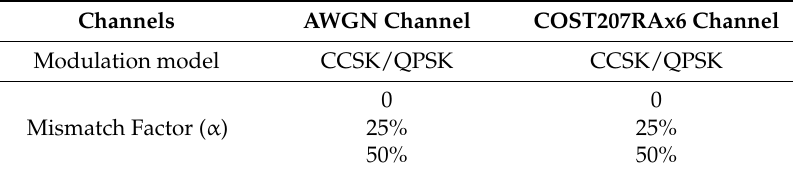
Table 1. Simulation